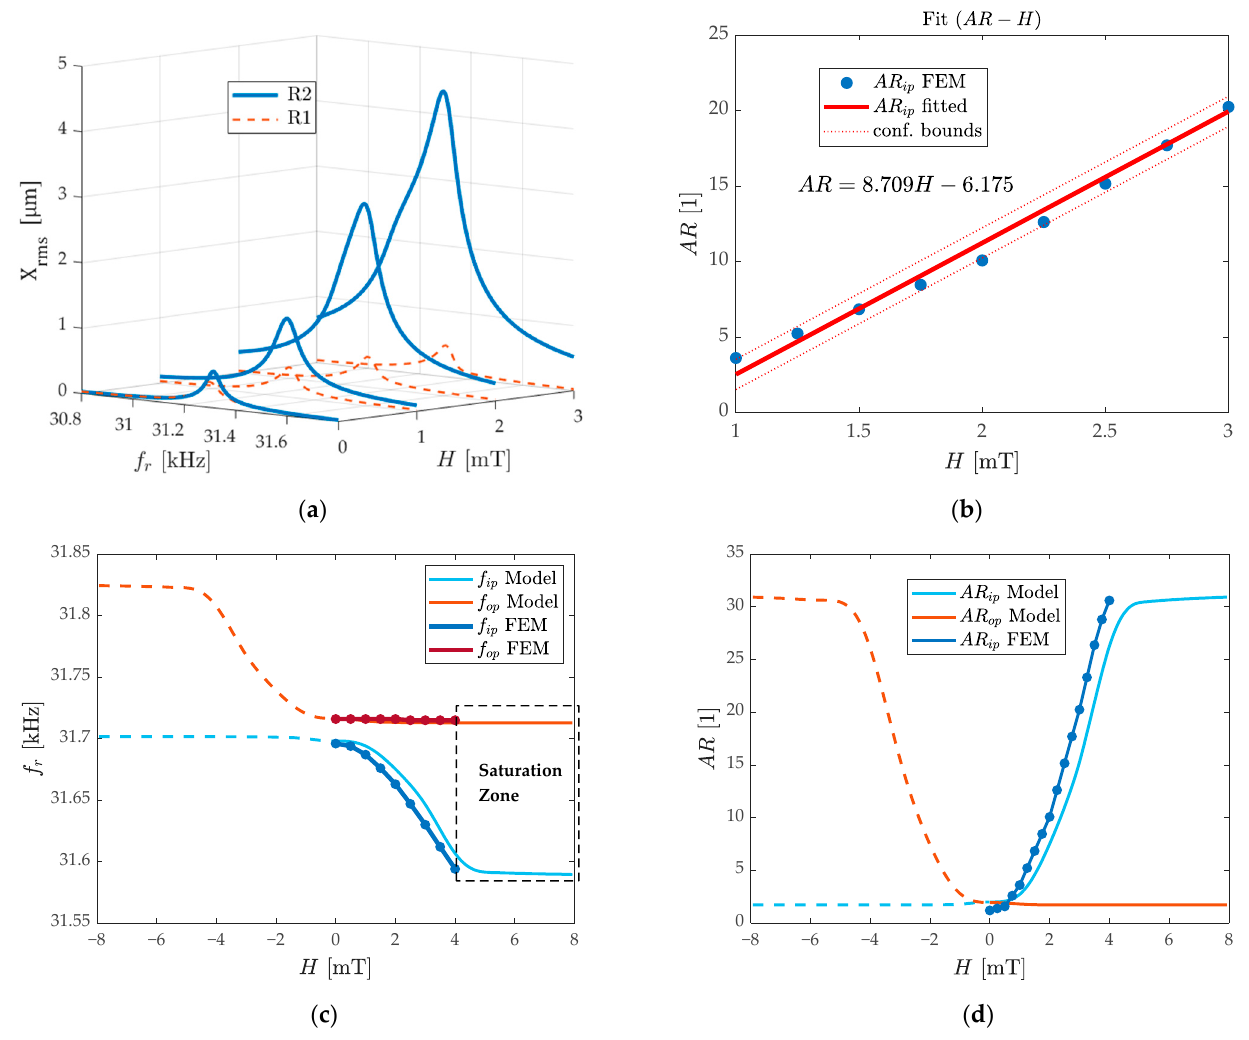
Figure 4. The analytical model and FEM simulation to verify the mode localization effect under the magnetic field disturbance in the WCR: ( a ) the frequency response of R1 and R2 are represented using the displacement RMS magnitude when the applied magnetic field varies from 0 to 3 mT; ( b ) fitting curve of the linear correlation between amplitude ratio and magnetic field with 95% confidence bounds and R 2 = 0.988; ( c ) prediction of the eigenfrequency response of the IP and OP modes on the external magnetic field within the comparison of the model prediction and FEM. The dashed box represents the sensor saturation area; ( d ) prediction of the amplitude ratio response of